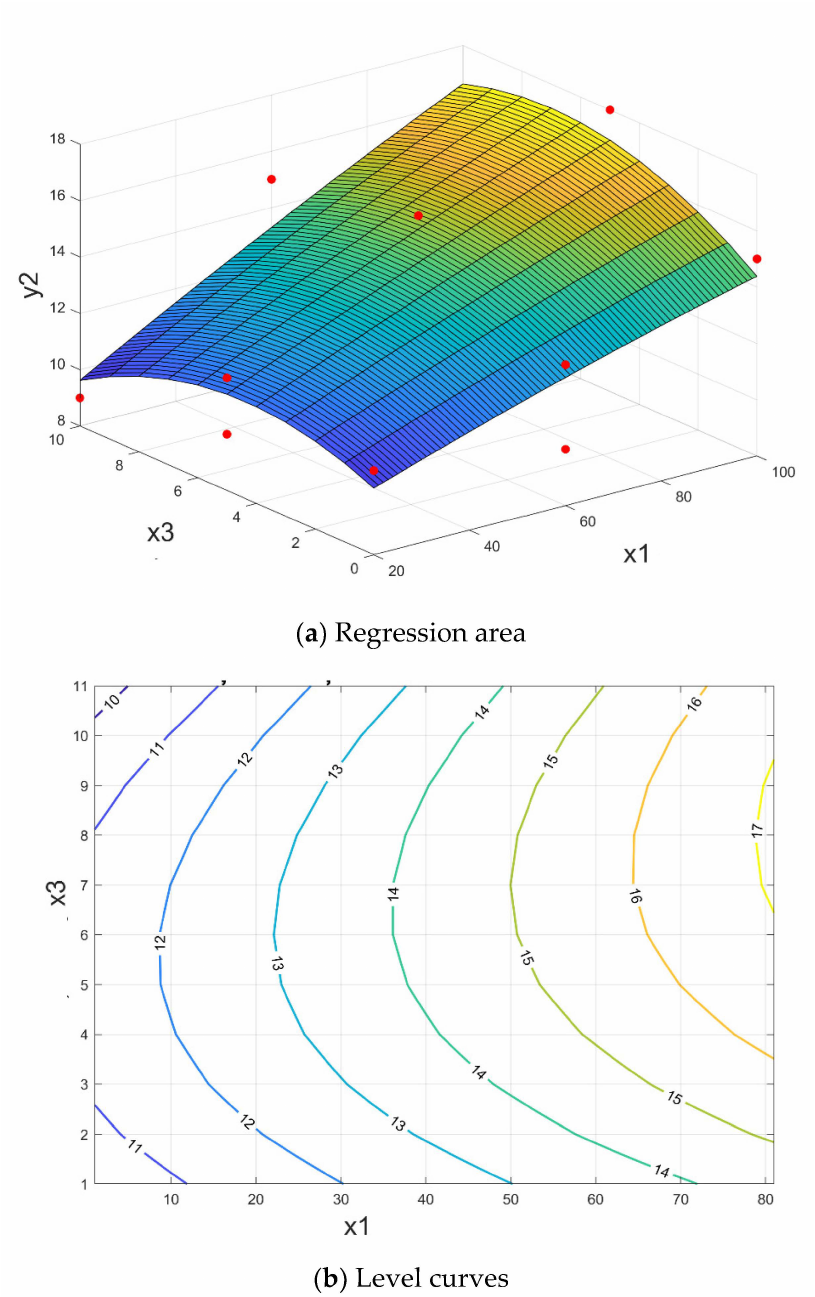
Figure 14. The briquettes resistance to crushing depending on the proportion of ferrous sludge and